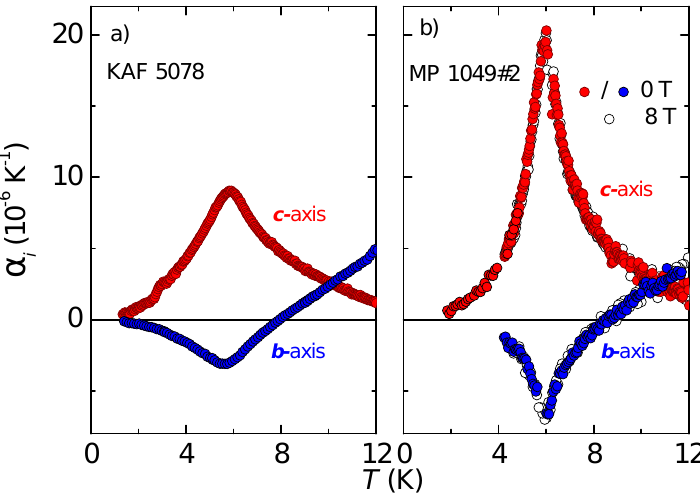
Figure 2. Thermal expansion coefficients for κ -(BEDT-TTF) 2 Cu 2 (CN) 3 measured along the in-plane b - and c -axis around the 6 K phase transition: ( a ) on single crystal from batch KAF 5078 reported in [8], ( b ) on single crystal MP 1049#2 studied in this work, where the anomalies are most strongly pronounced. For this crystal also data taken in a magnetic field of B = 8 T applied along the measuring direction are shown.